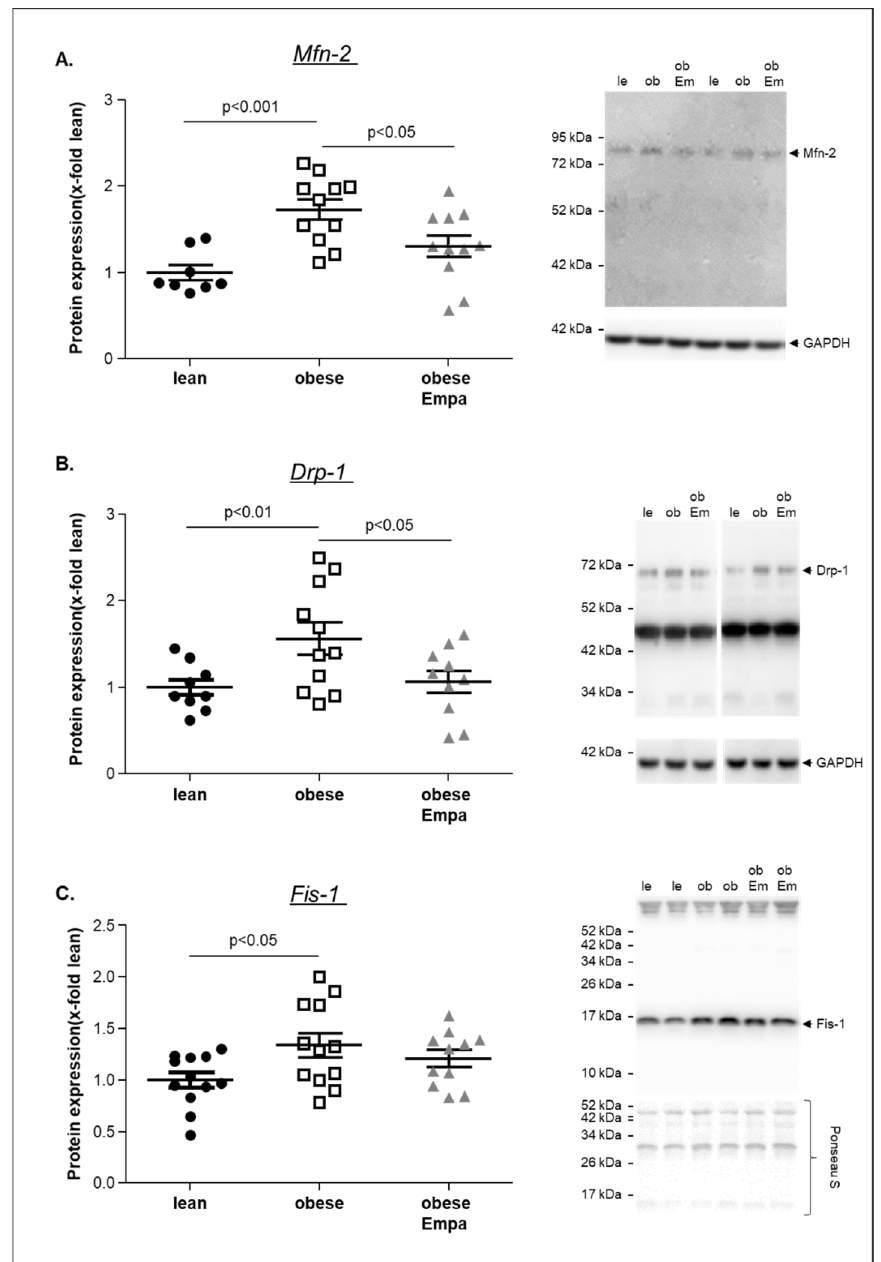
Figure 6. Protein expression of mitofusin-2 (Mfn-2) ( A ), Drp-1 ( B ) and Fis-1 ( C ) was quantified by western blot analysis in soleus muscle homogenates obtained from ZSF1-lean (lean, black circles), ZSF1-obese (obese, open squares) and ZSF1-obese rats treated with Empagliflozin (obese + Empa). Representative western blot is depicted. Results are expressed as mean ± SEM ( n = 9–11 per group).